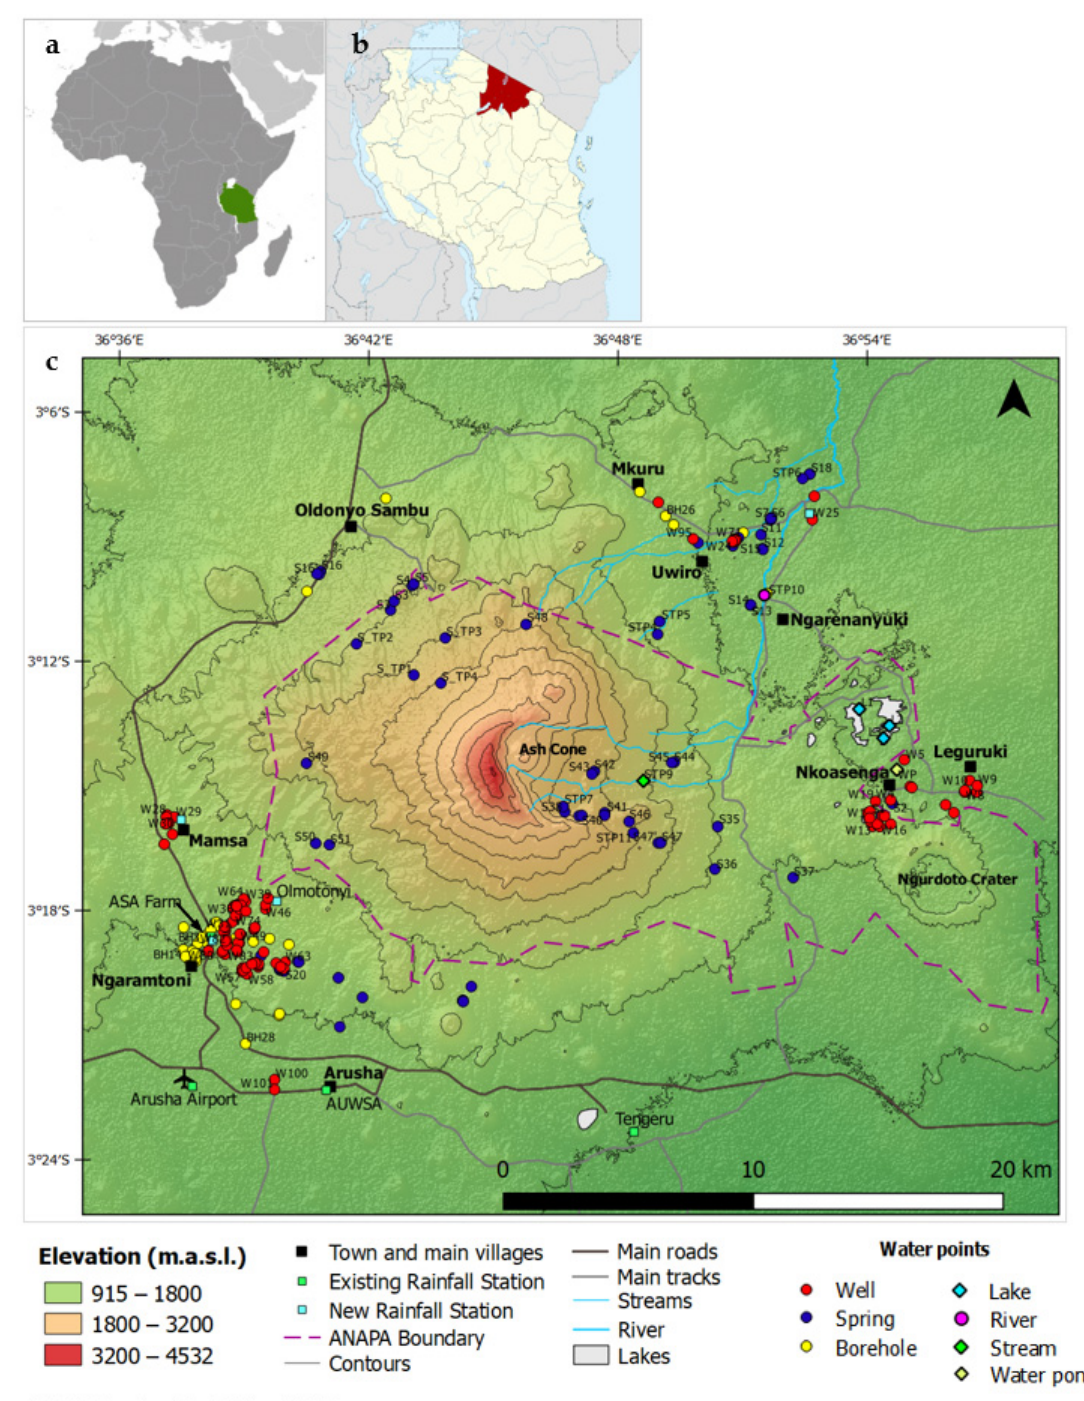
Figure 1. ( a ) Map of Africa showing the location of Tanzania (Source: CIA [25], the image is copyright free), ( b ) map of Tanzania showing the Arusha region (Source: Wikipedia [26], the image is under an open access Creative Commons CC BY 4.0 license; credit line: Sémhur/Wikimedia Commons/CC-BY-SA-3.0) and ( c ) map showing the spatial distribution of inventoried water points in the study area (water points with label were sampled for chemical analysis).